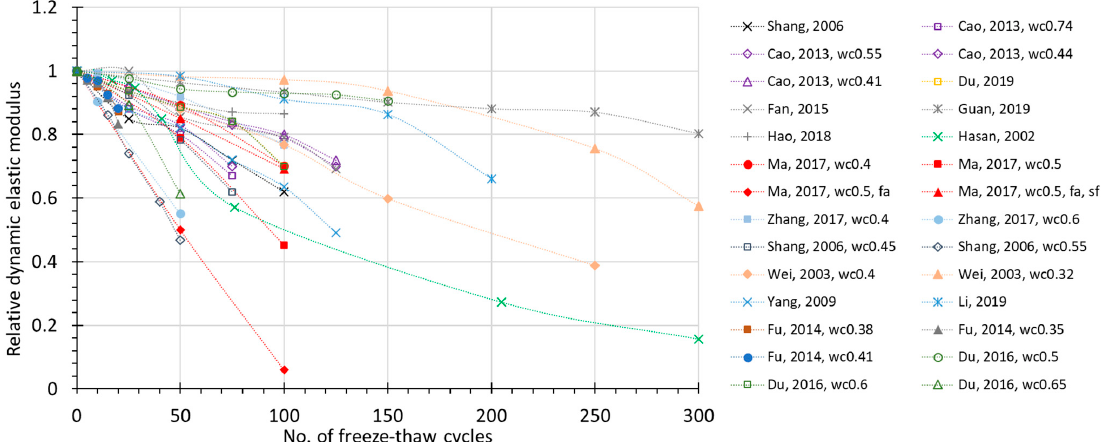
Figure 2. Relative reduction in compressive strength during FTC for non-air-entrained concrete (for the same literature, wc —water to cement ratio; fa —fly ash added; sf —silica fume added).